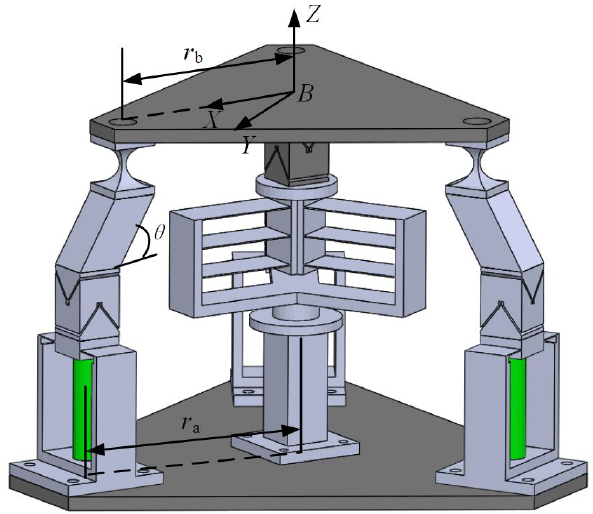
Figure 11. 3 PUS/PU(1) compliant parallel